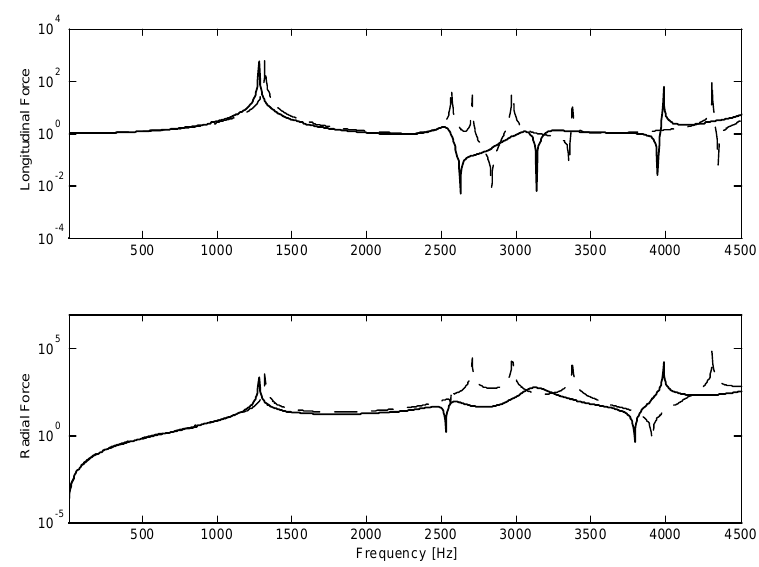
Fig. 15. Transmitted force: type (B) tapered shell (solid), uniform shell (dashed).